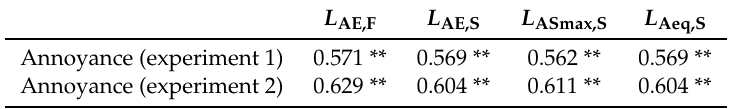
Table 6. Pearson’s r for correlations between a series of sound level variables and annoyance. L